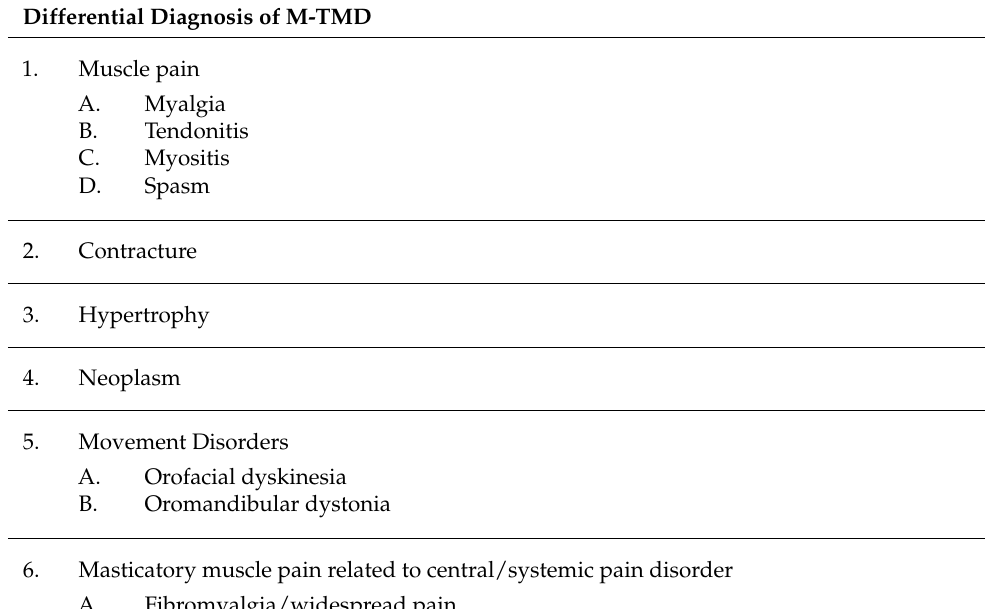
Table 1. Differential diagnosis of M-TMDs according to the DC/TMD classification.